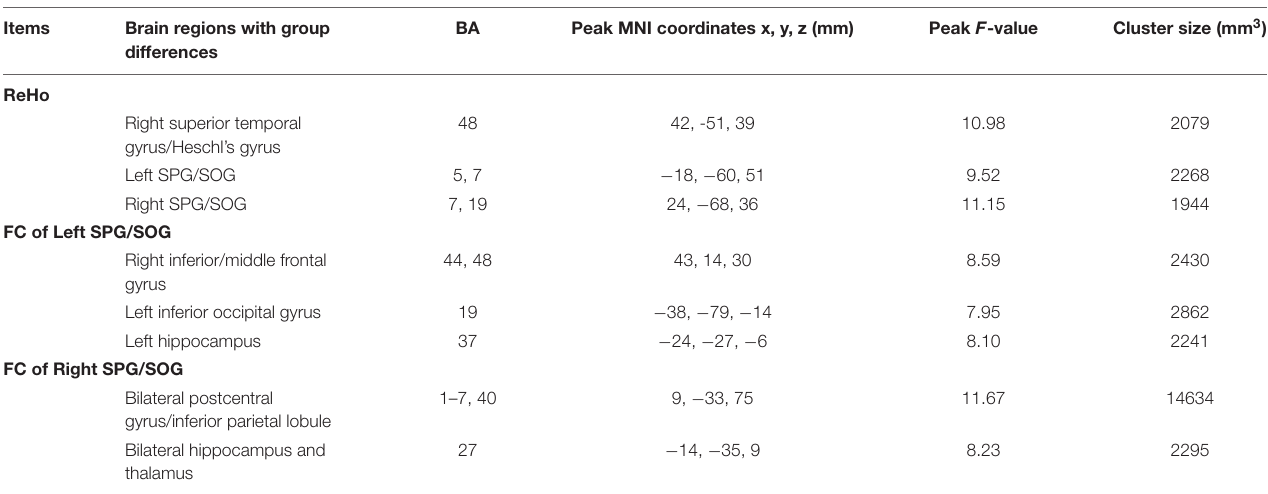
TABLE 2 | Brain regions with group differences of ReHo or FC.